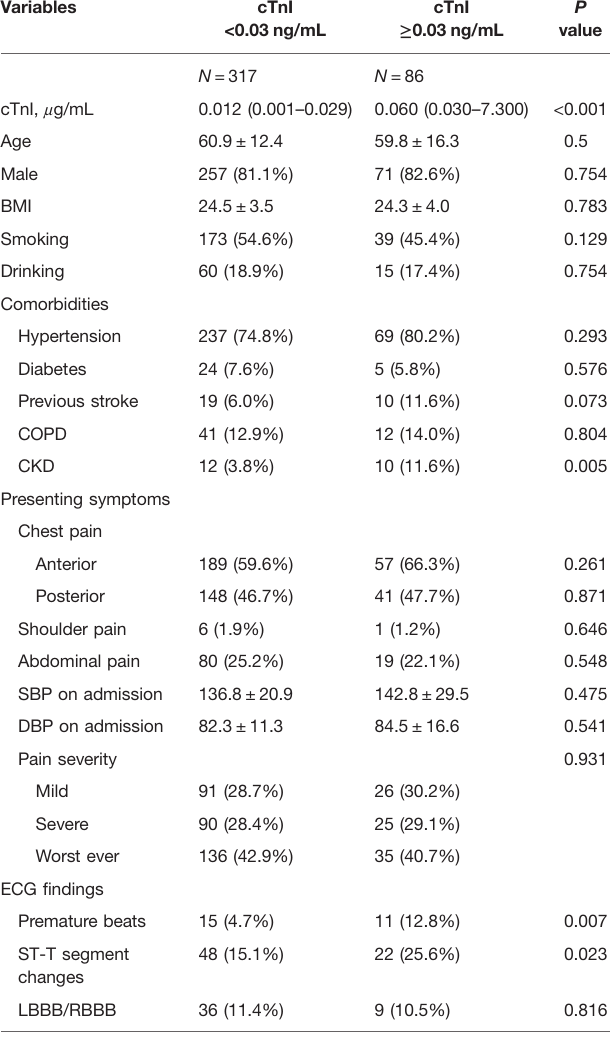
TABLE 1 | Baseline characteristics of acute type B aortic dissection patients strati fi ed with cTnI <0.03 ng/mL and ≥ 0.03 ng/mL